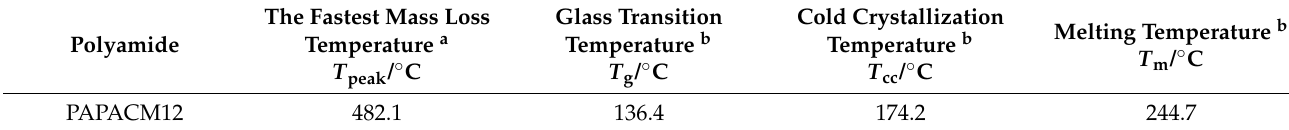
Figure 1. The repeating unit of poly(4,4 ′ -aminocyclohexyl methylene dodecanedicarboxylamide) (PAPACM12). Table 1. The thermal properties of PAPACM12.